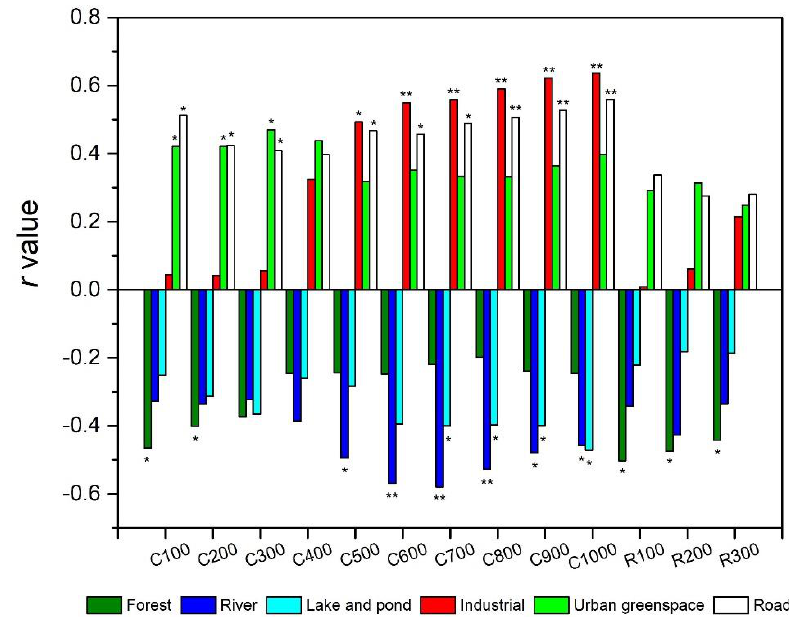
Figure 6. Correlations between TN and the areas of particular land uses under the circular and riparian buffer scales at different spatial scales based on a Spearman’s rank correlation analysis. The one-asterisk (two-asterisk) superscripts denote above 90% (95%) confidence levels. Note that only the land uses that significantly correlated with the TN were shown.